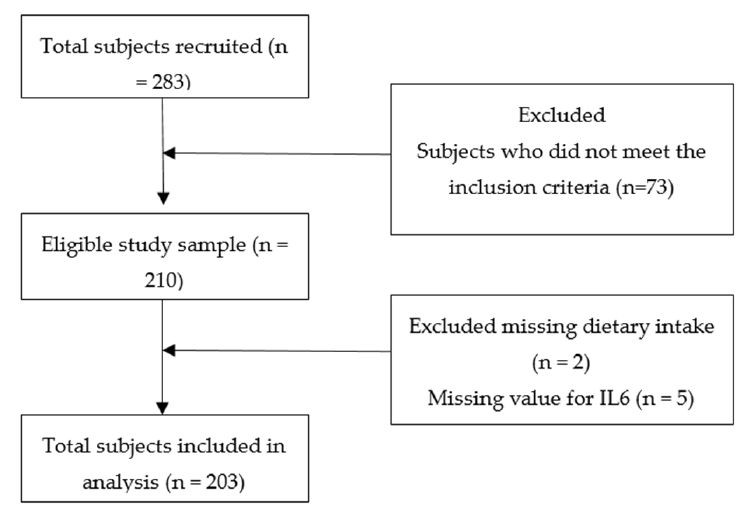
Figure 1. Flow diagram of the study.